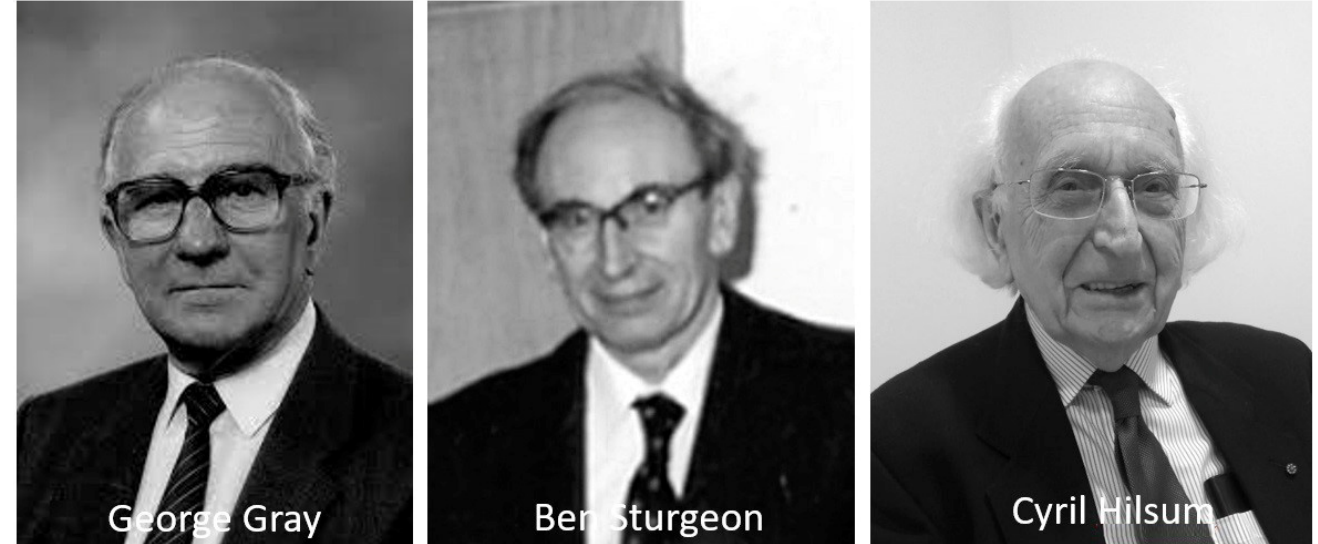
Figure 5. UK liquid crystal scientists who were instrumental in the development of the LCD technology: George Gray, Ben Sturgeon, and Cyril Hilsum.